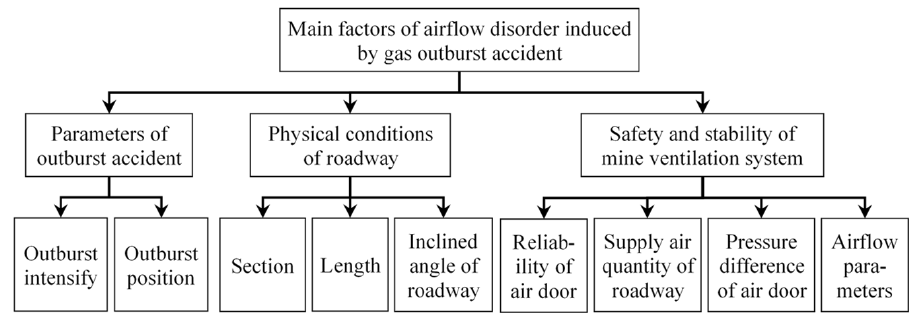
Figure 3. Hierarchical structure of factor indicators.